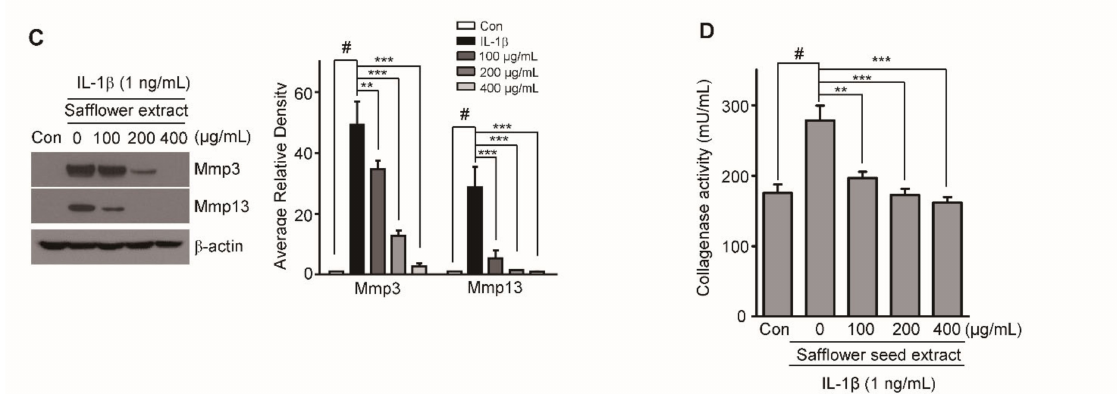
Figure 2. Safflower seed extract reduces matrix metalloproteinases (MMP3 and MMP13) expression in articular chondrocytes induced by IL-1 β . Chondrocytes were treated with IL-1 β (1 ng/mL) in a time-dependent manner ( A ) and co-treated with different concentrations (100, 200, and 400 µ g/mL) of safflower seed extract ( B ). The mRNA expression levels of Mmp3 and Mmp13 were measured using RT-PCR ( A , B , left) and qRT-PCR ( A , B , right). The protein expression of MMP3 and MMP13 was determined by western blotting ( C , left) and quantified by densitometry ( C , right). Gapdh and β -actin were used as the loading controls. Collagenase activity in safflower seed extract-treated chondrocytes was evaluated using the Enzchek gelatinase/collagenase assay and detected by ELISA at 482/530 nm ( D ). Data are shown as mean ± SD of each group ( n = 5). # p < 0.05 compared with the control; * p < 0.05, ** p < 0.01, and *** p < 0.001 compared with the IL-1 β -treated or safflower seed extract-treated